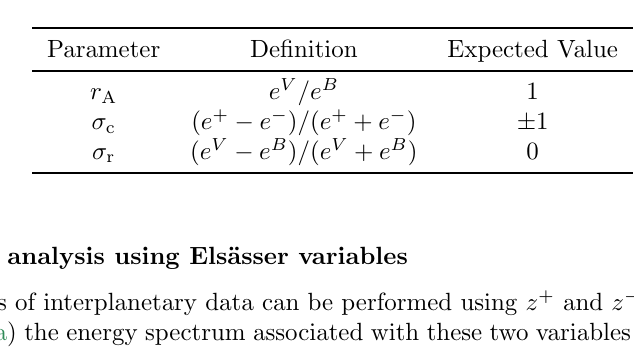
Table 10: Expected values for Alfv`en ratio 𝑟 A , normalized cross-helicity 𝜎 c , and normalized residual energy 𝜎 r for a pure Alfv`en wave outward or inward